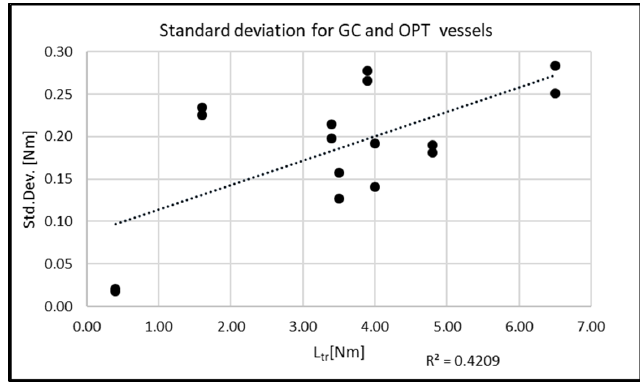
Figure 10. The standard deviation of the ship’s distance from the centre to the length of the leg.